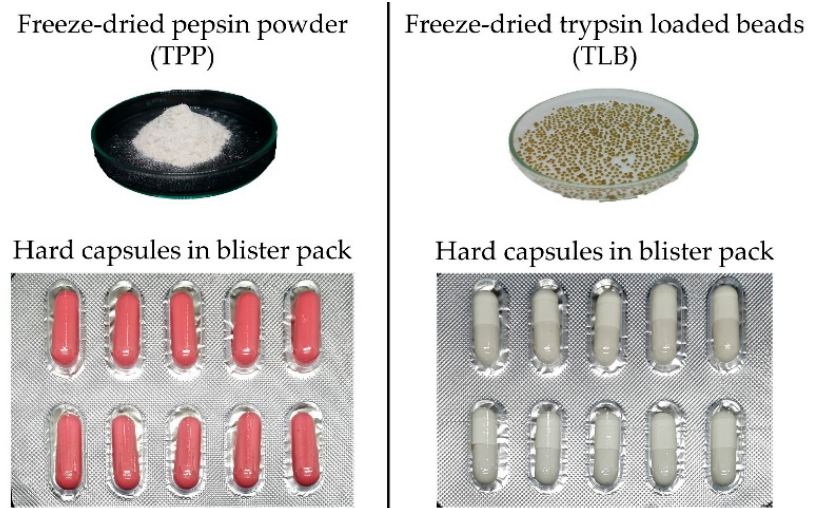
Figure 1. Freeze-dried pepsin powder (TPP) and trypsin loaded beads (TLB) filled into hard capsules and packed in blister packs.